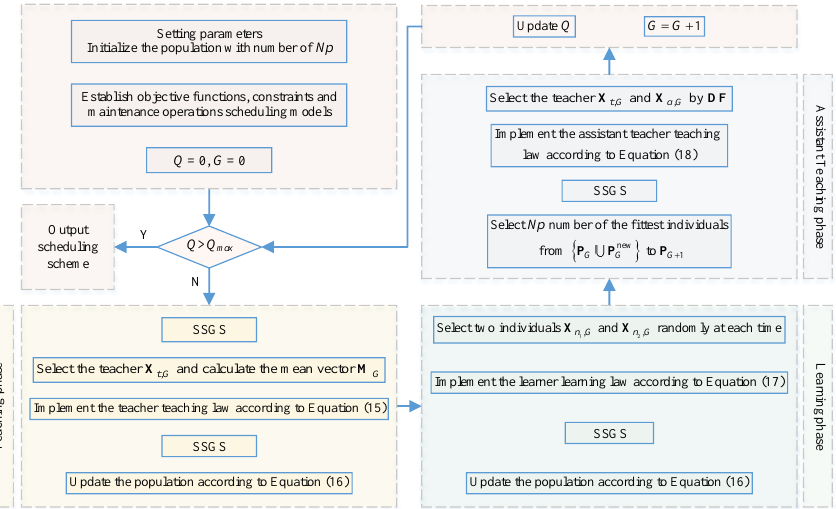
Figure 9. Flowchart for improved teaching-learning-based optimization algorithm with a serial scheduling generation scheme (ITLBO-S).